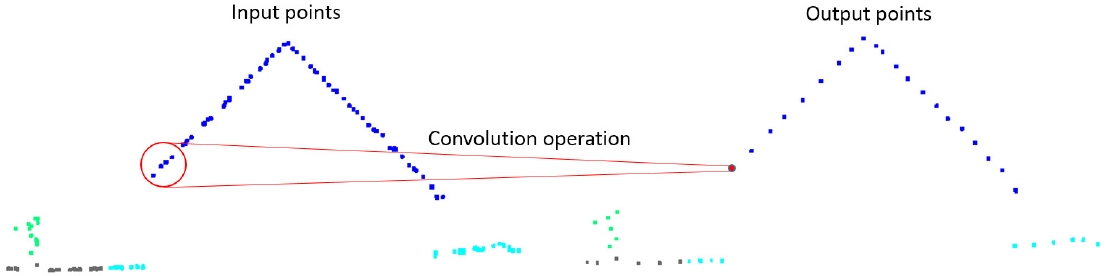
Figure 3. Convolution layer process simulated on a small area of ALS point cloud.